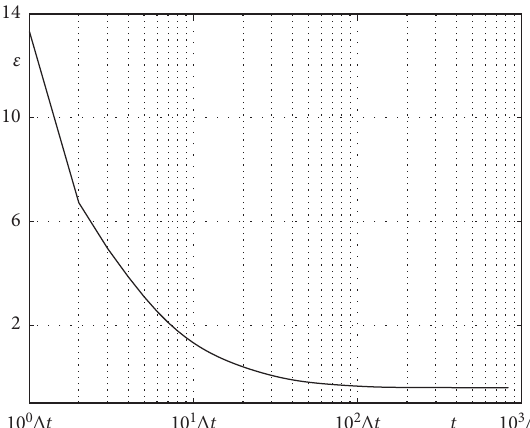
Figure 7: Temporal evolution of the objective function E with respect to the iteration of the algorithm for “The Venice Merchant”